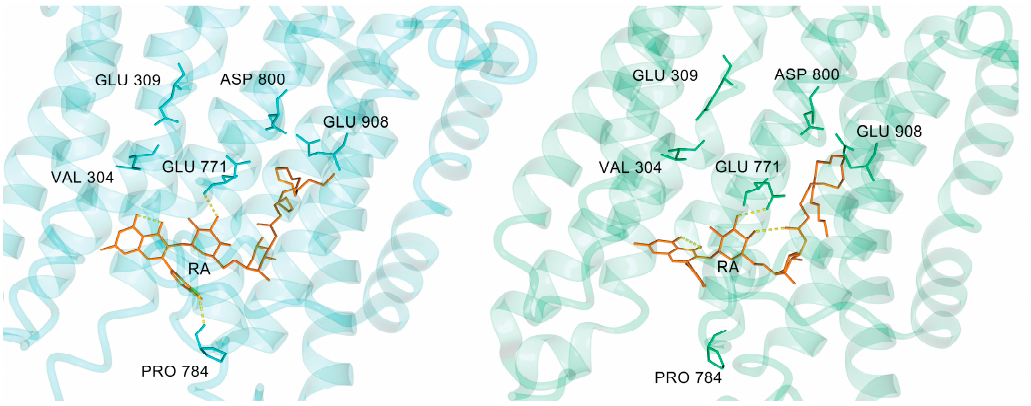
Figure 8. Conformation of RA (orange) and the nearby residues at the beginning (left panel; cyan) and after 200 ns (right panel; green) MD simulation. Hydrogen bonds are displayed as yellow dashed lines. An inward-to-outward carboxyl group side-chain transition of Glu309 during the MD simulation can also be seen. Figures rendered using YASARA [42]. SERCA1a performs a complicated multistep catalytic process (see Figure 9), where individual steps depend on a lot of parameters characterizing the luminal, membrane, and cytoplasm environment (ATP, Mg 2+ , and Ca 2+ concentrations, acidity on both sides, temperature, membrane composition) as well as regulators (sarcolipin, phospholamban). Inspecting the E2 states related to the inhibition of RA (without calcium ions inside), we can see that all states without metal ions were characterized by protons occurring in the calcium-binding sites. The rate constant of complete dephosphorylation of E2P → E2 for wild type SERCA1a was measured as k = 0.11 s − 1 . On the other hand, the rate constant of E2 → 2Ca 2+ E1 was estimated as almost one order higher, k = 0.9 s − 1 [59]. That is , the rate-limiting step (or set of steps) for the second period of SERCA1a activity cycle was the E2P → E2 transition.